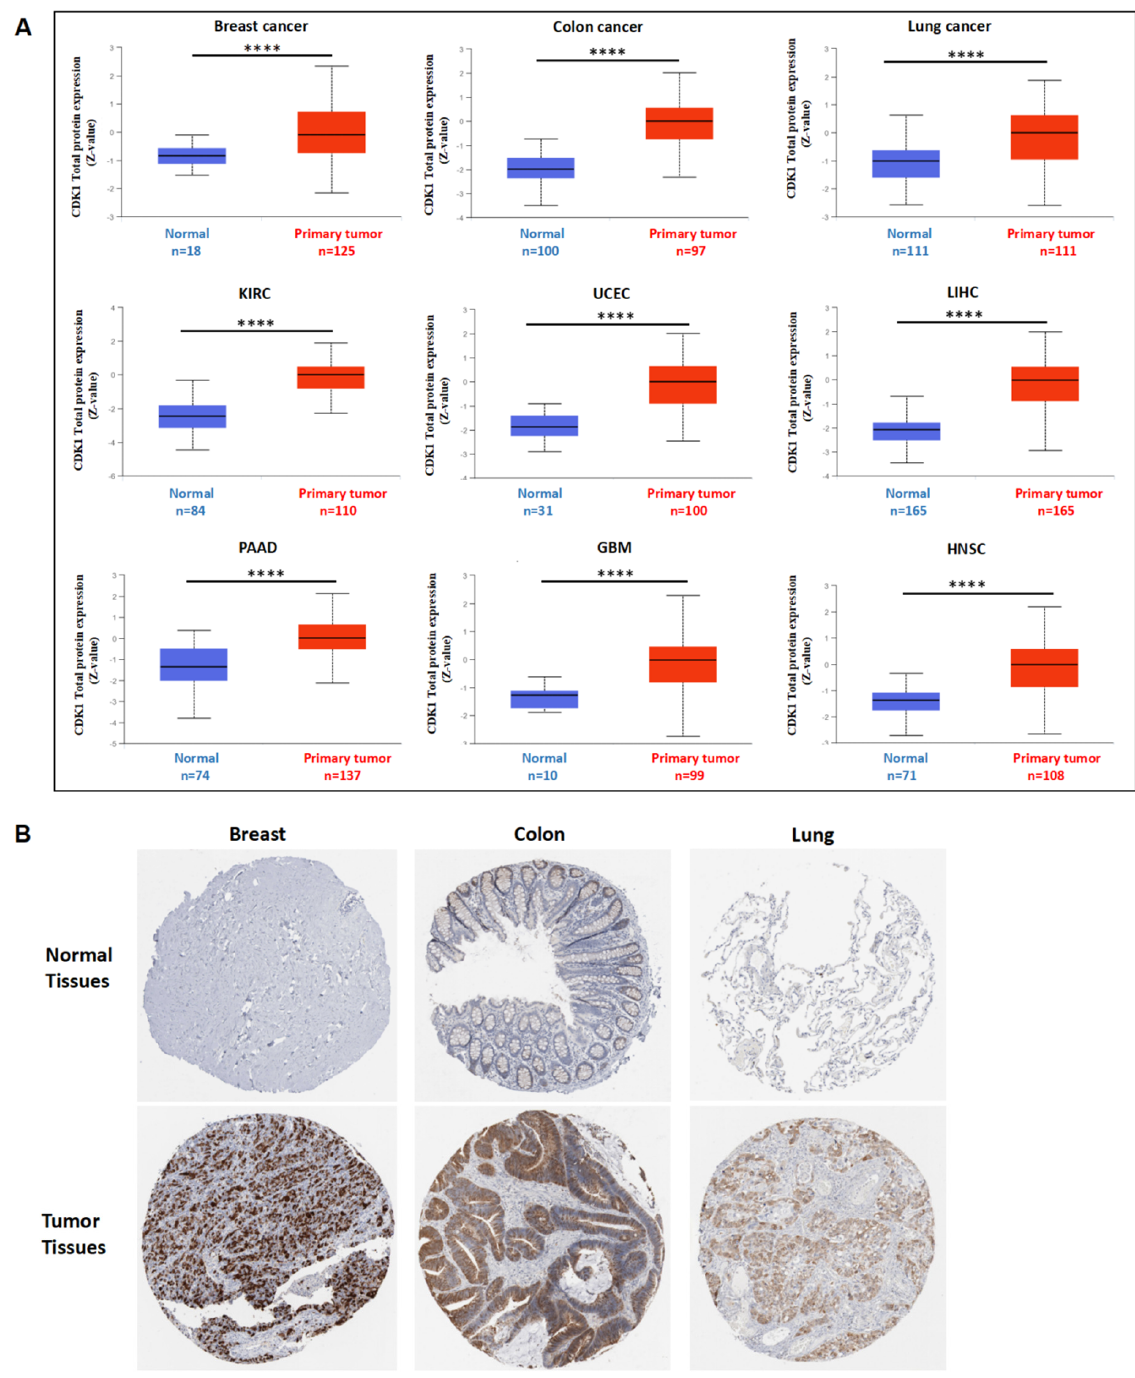
Figure 3. CDK1 protein expression in various tumors and normal tissues. ( A ) The total CDK1 protein expression was significantly higher in primary tumors as compared to normal tissues from the CPTAC database; for a given cancer type, Z-value represents the standard deviation from the median across samples. **** p < 0.0001, Student’s t -test. ( B ) Immunohistochemistry staining images of CDK1 in human breast, colon, and lung from the HPA database.